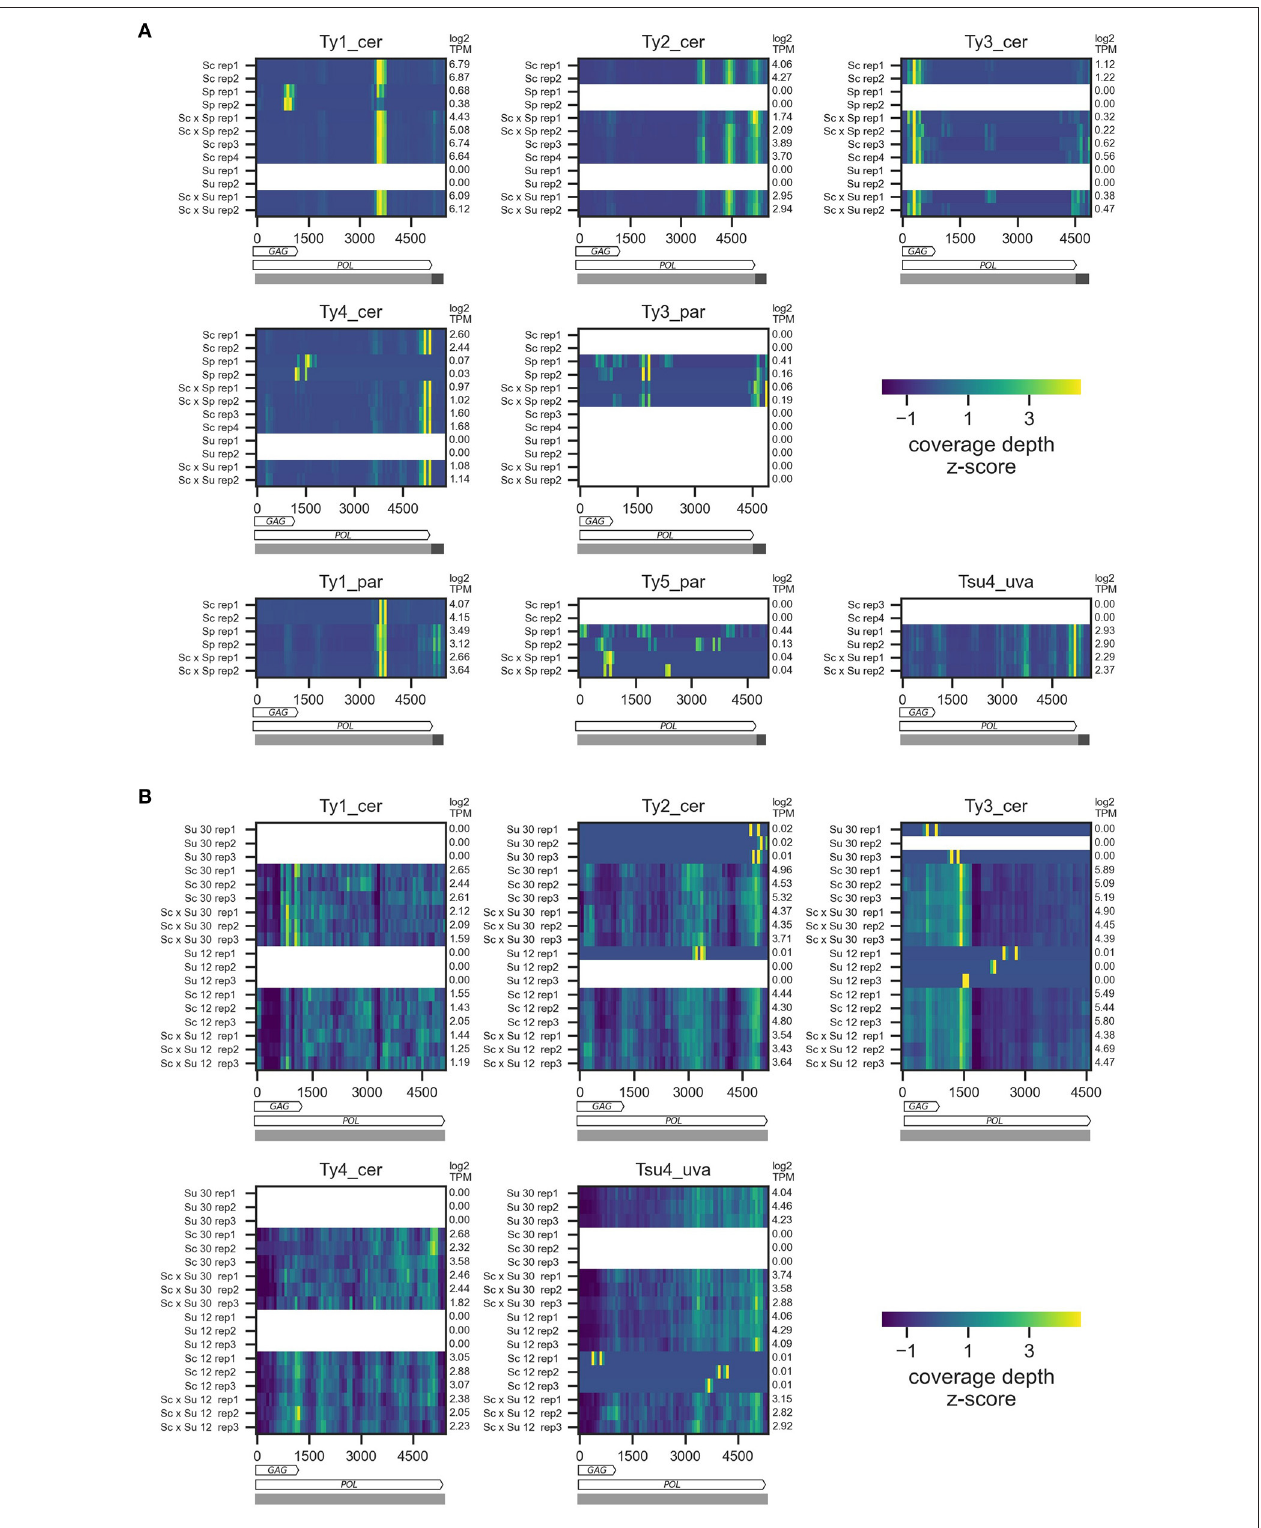
FIGURE 2 | RNA sequencing coverage depth along Ty reference sequences for DS1 (A) and DS2 (B) . Z-scores of mean coverage depth are shown for each sample by 75 bp-wide non-overlapping bins along Ty reference sequences. In (A) , rows show the two replicates for each parental species and hybrids. In (B) , rows show